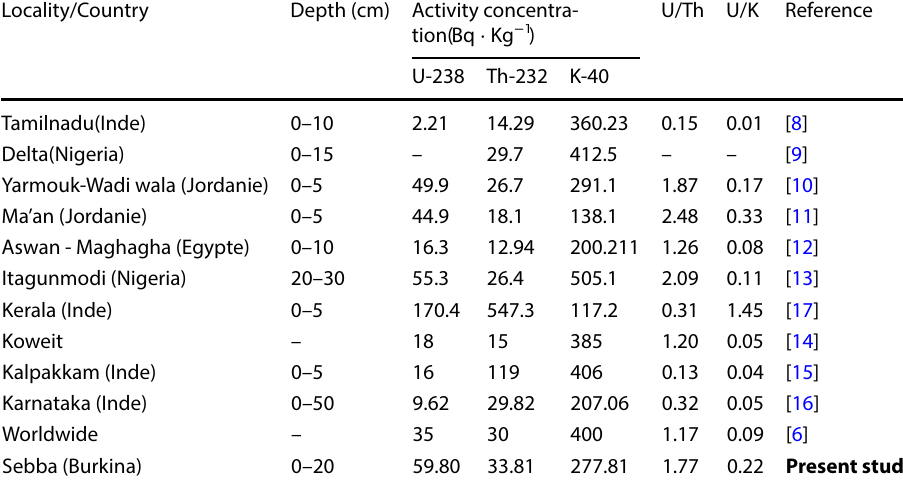
Table 3 Activity concentration of 238 U , 232 Th and 40 K measured worldwide